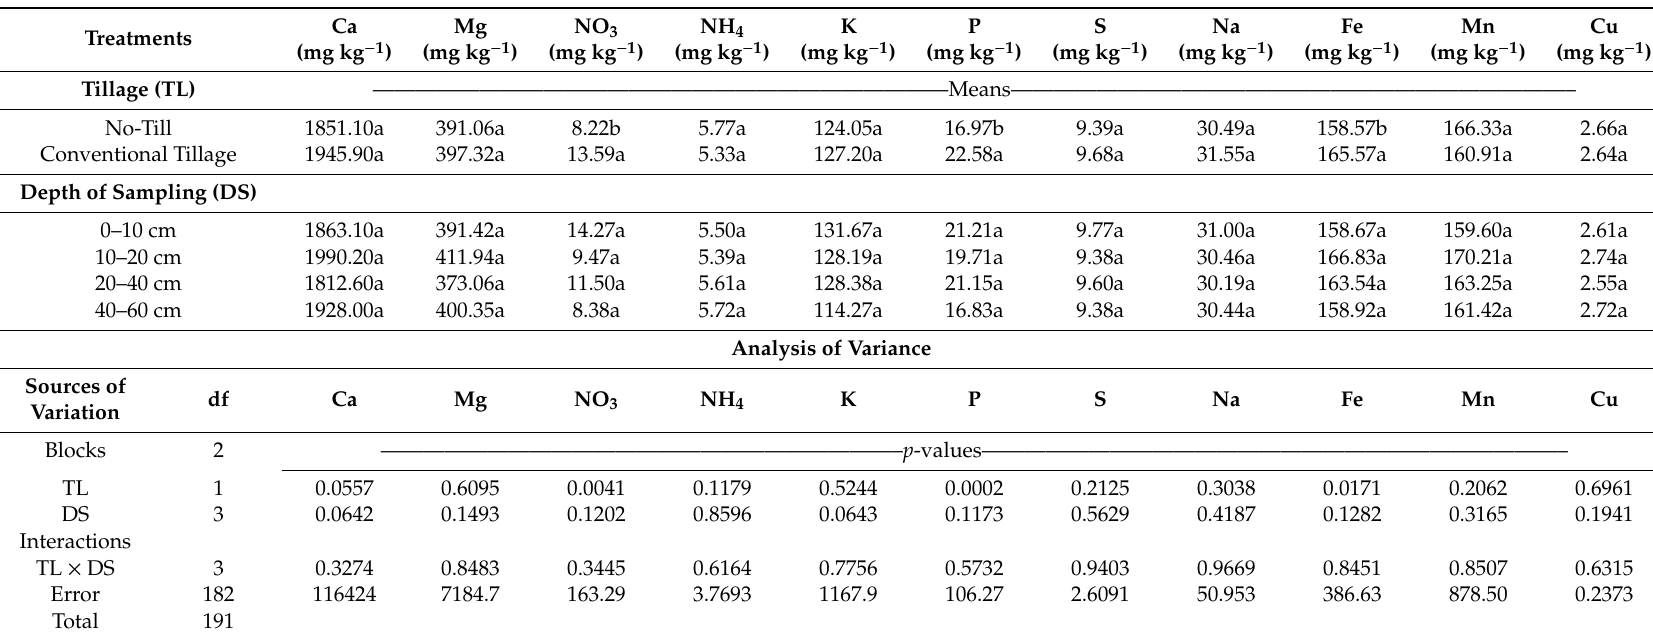
Table 2. E ff ects of tillage and depth of sampling on selected soil nutrients in